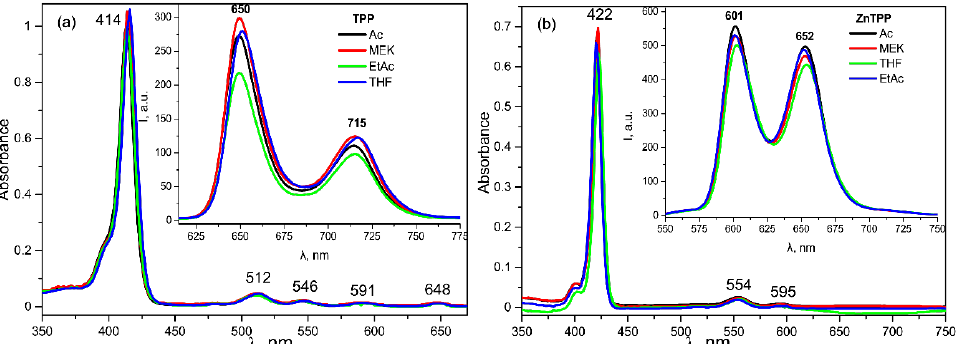
Figure 11. Electronic absorption and fluorescence (insert) spectra for TPP ( a ) and ZnTPP ( b ) in different solvents.